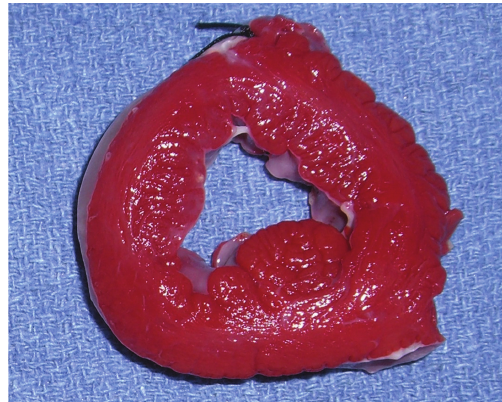
Figure 4: No macroscopic infarction was seen in postmortem TTC- stained myocardium. TTC: triphenyltetrazolium